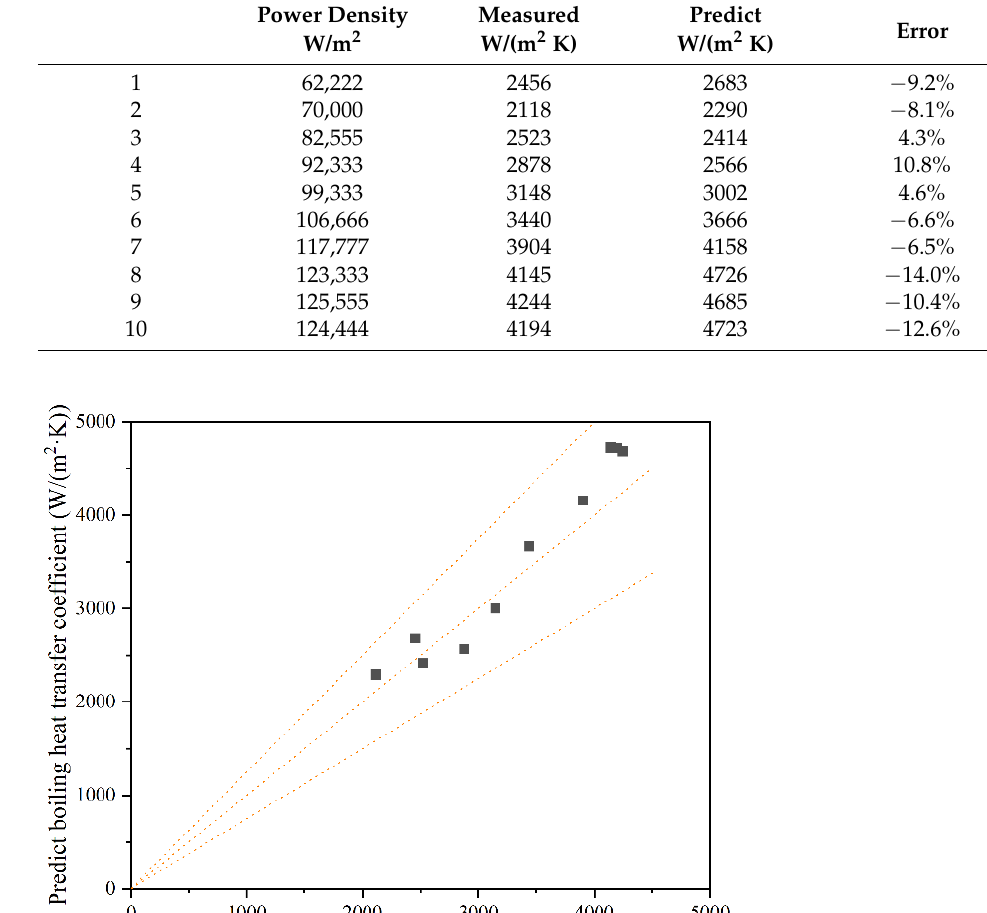
Table 2. Error comparison between measured and predicted boiling heat transfer coefficients.